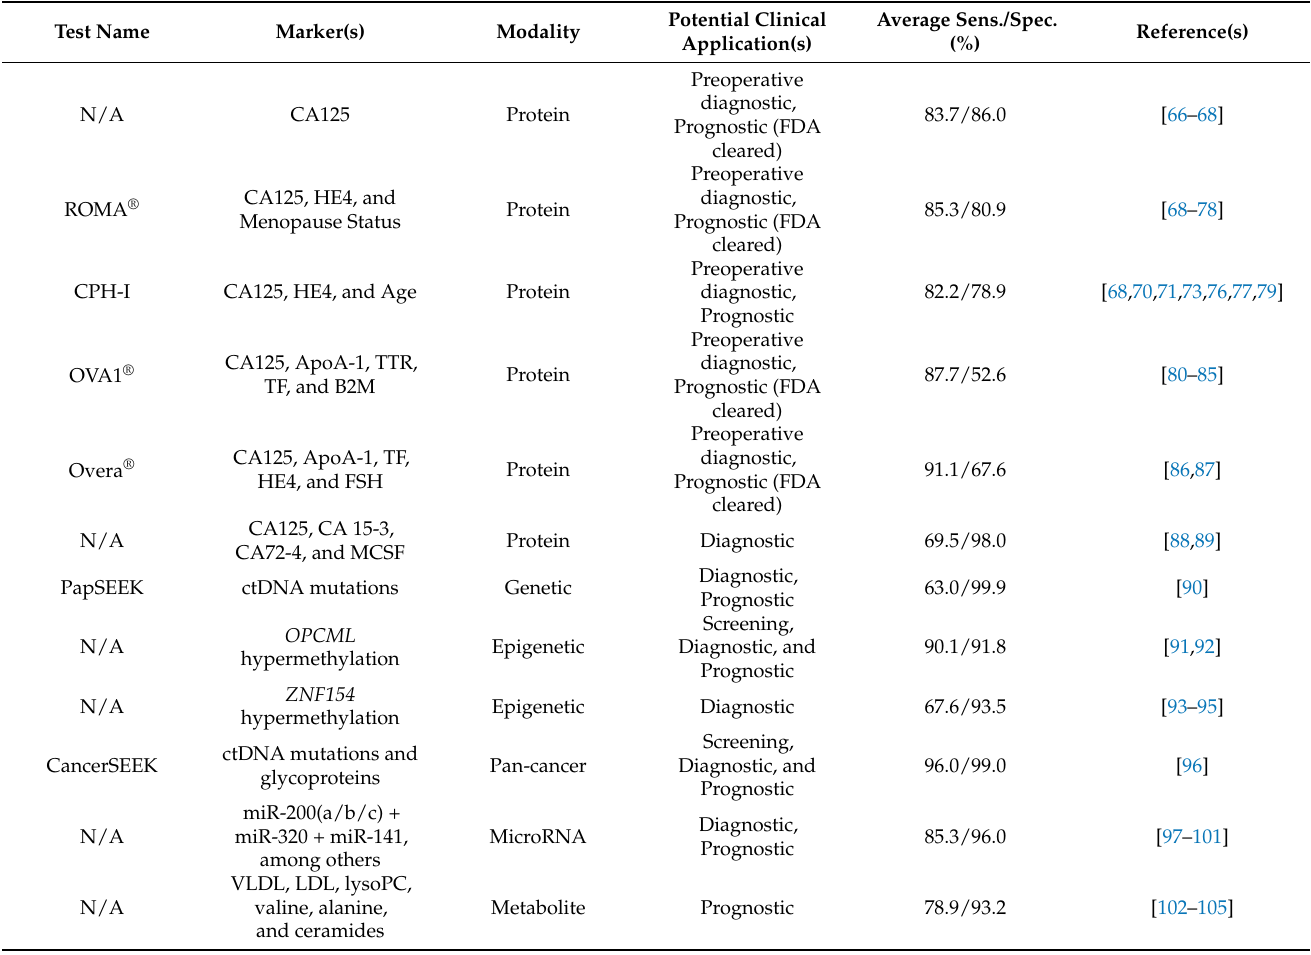
Table 1. Select biomarker screening assays for the detection of epithelial ovarian cancer average specificity and sensitivity were calculated from studies with at least 250